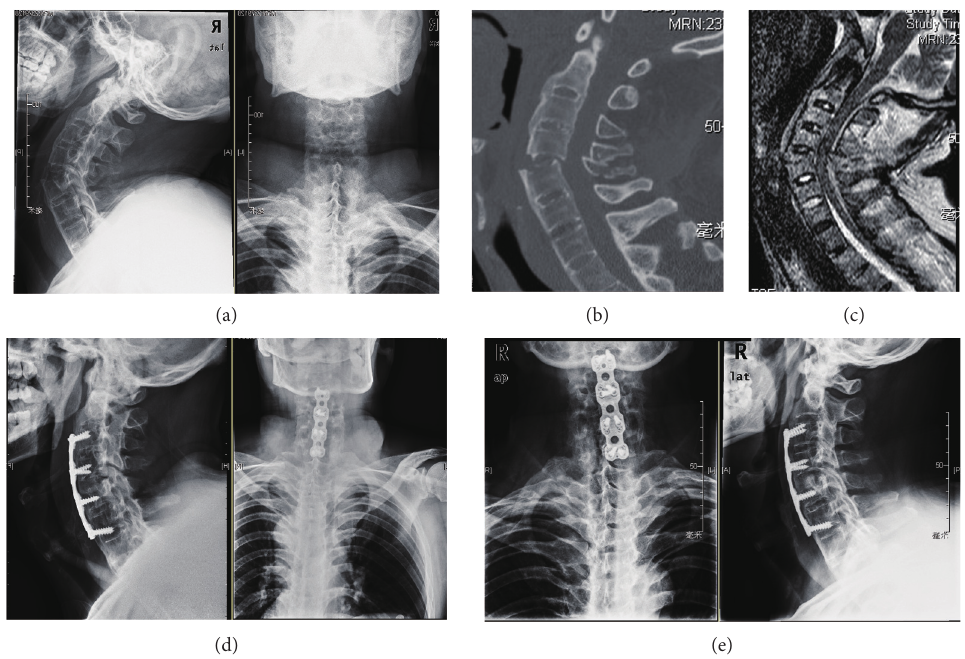
Figure 8: Type I fracture. An anterior approach is adopted. The length of the plate should be extended by more than two